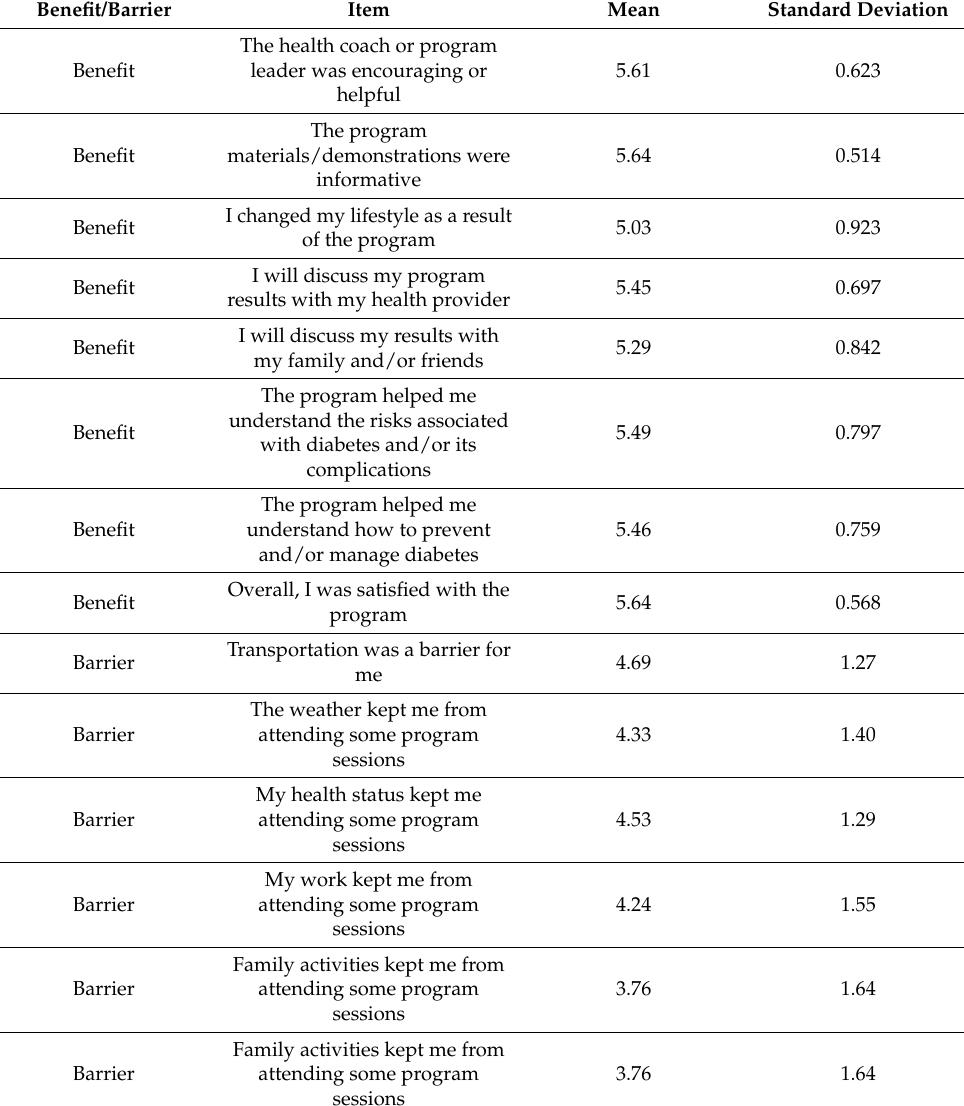
Table 3. Benefits and barriers items (benefits n = 69, barriers n =